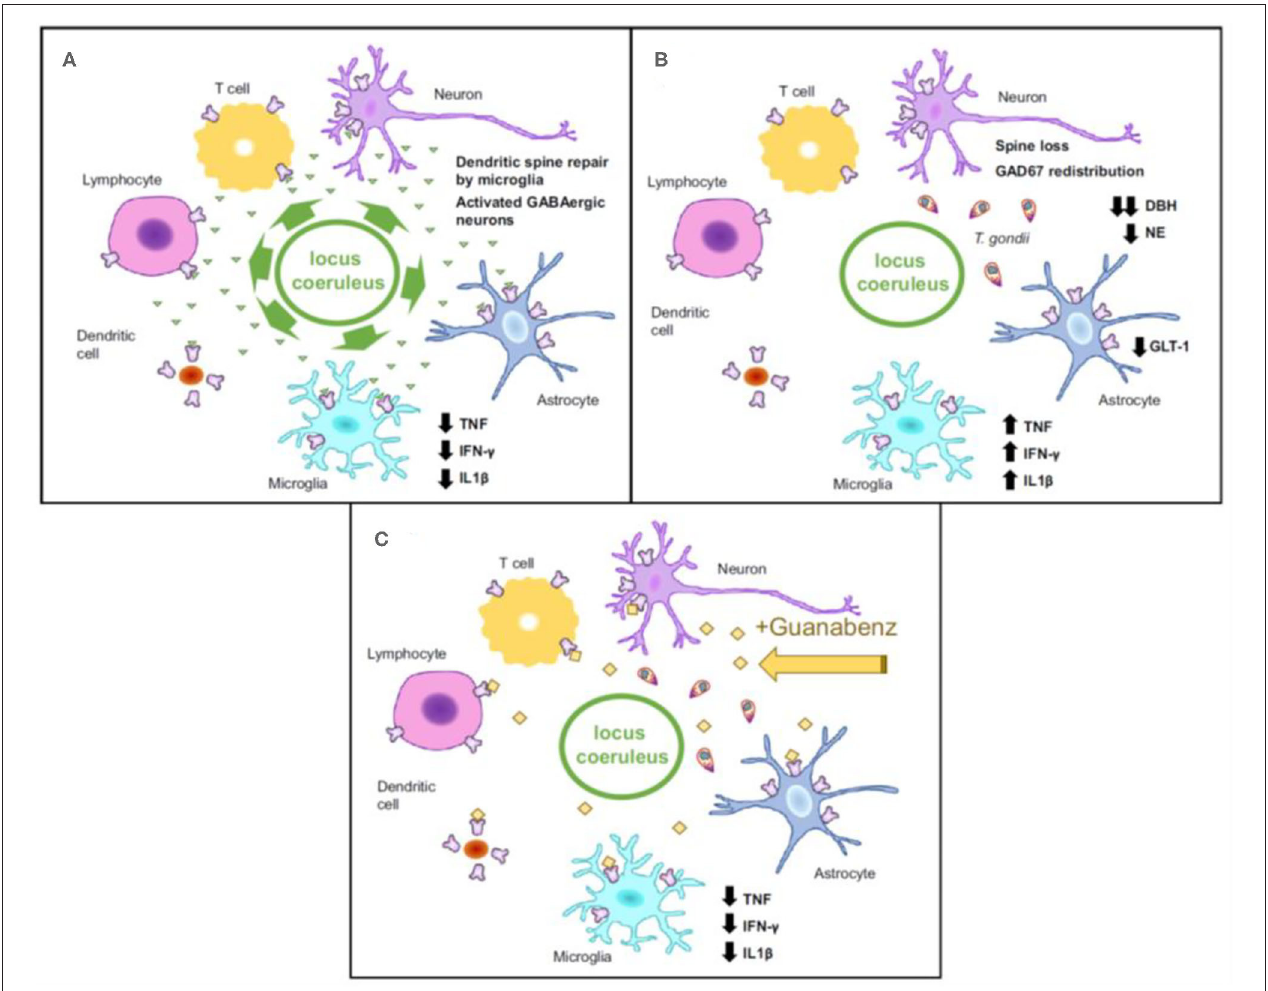
FIGURE 11 | Schematic illustrating the regulation of inflammatory response by noradrenergic neurotransmission during an infection in the rodent brain. (A) Norepinephrine (NE, green triangles) is released from locus coeruleus noradrenergic neurons that are functioning normally. NE binds to adrenergic receptors located on immune cells, astrocytes, neurons, and microglia. Microglia and GABAergic neurons are activated by NE, cells that help with downregulation of pro-inflammatory cytokines and neuronal dendrite repair. (B) In rodents, neurons have been reported to undergo several changes in response to chronic T. gondii infection, including severe reduction in NE and dopamine- β -hydroxylase (DBH), within noradrenergic neurons, redistribution of GAD67 (an enzyme involved in GABA synthesis), and loss of dendritic spines. Additionally, reduced glutamate transporter Glt-1 has been observed in astrocytes of rodents chronically infected with T. gondii . Elevation in the levels of inflammatory cytokines, including interleukin (IL)-1 β , tumor necrosis factor (TNF) and interferon (IFN)- γ also occurs. The model from Laing et al. states that since noradrenergic signaling is suppressed during chronic T. gondii infection, the brakes on inflammation are lifted leading to increased cytokine concentrations. The behavioral alterations seen in rodents chronically infected with T. gondii could be partly explained by these changes. (C) Laing et al. suggest that the elevated pro-inflammatory cytokines can be suppressed and the lack of NE can be compensated for (at least partially) by treating the T. gondii -infected rodents with Guanabenz (a noradrenergic agonist), which has been linked with reversal of T. gondii infection-induced hyperlocomotion in rodents) [Reprinted from (363); Copyright (2020); with permission from Elsevier; License #